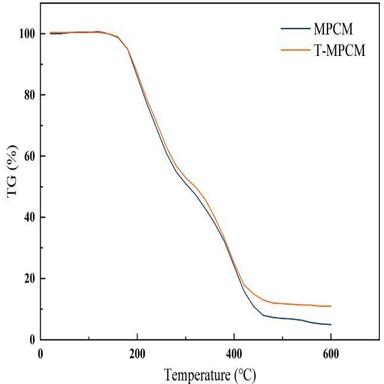
TGA curves of MPCM and T-MPCM.